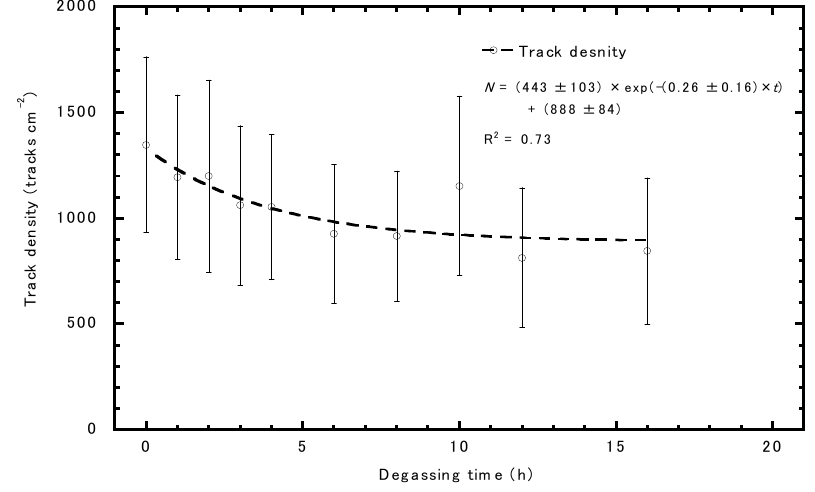
Figure 4. The alpha track density against the degassing time.